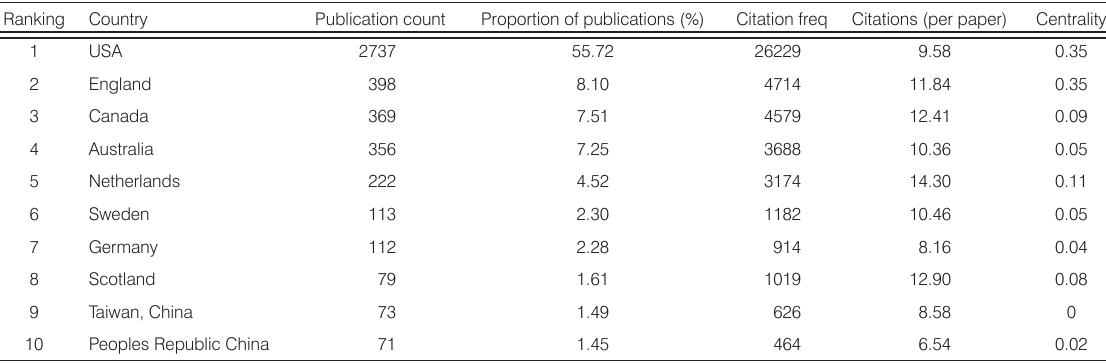
Table 3. Publication and citation frequency of the top 10 productive countries and regions.